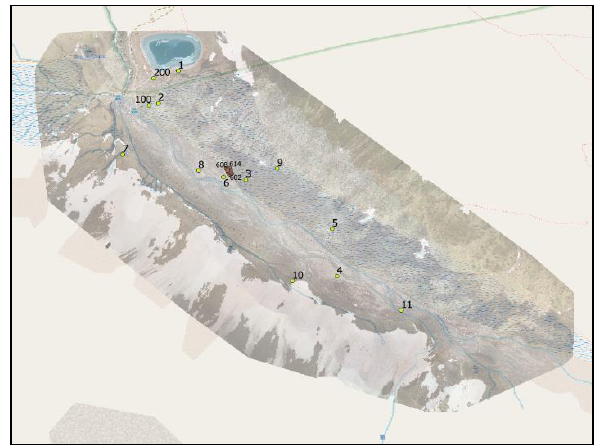
Figure 3. Distribution of GCPs for the 2019 campaign